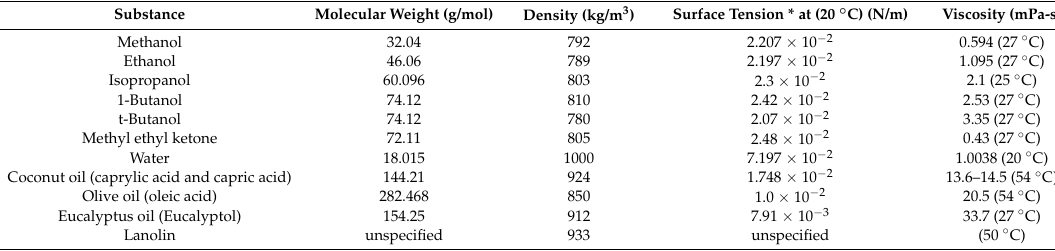
Table 1. Properties of substances used to demonstrate